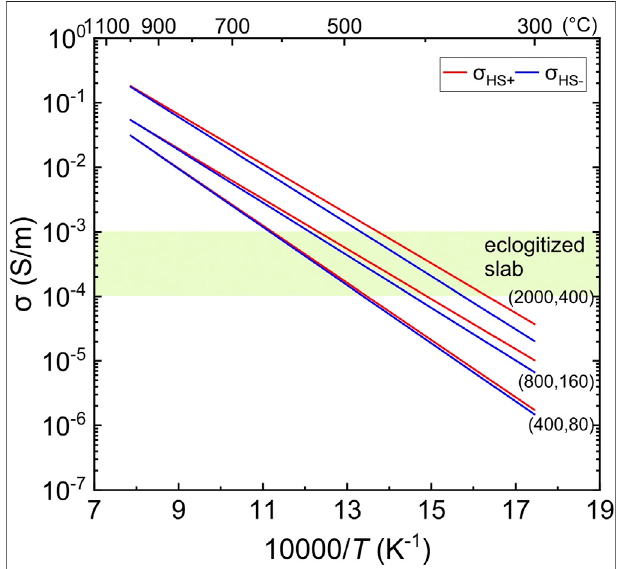
FIGURE4| Bulkconductivityofeclogiteforamodalcompositionof50% omphacite + 50% garnet. The assumed water contents are 400, 800, and 2,000 ppmH 2 Oforomphaciteand80,160,and400 ppmH 2 Oforgarnet(see text). The shaded region marks the estimated conductivity of the eclogitized crust at 70 – 120 km depth by electromagnetic surveys (Vanyan et al., 2002;McGary et al.,2014; Ichiki et al.,2015; Araya Vargaset al., 2019).